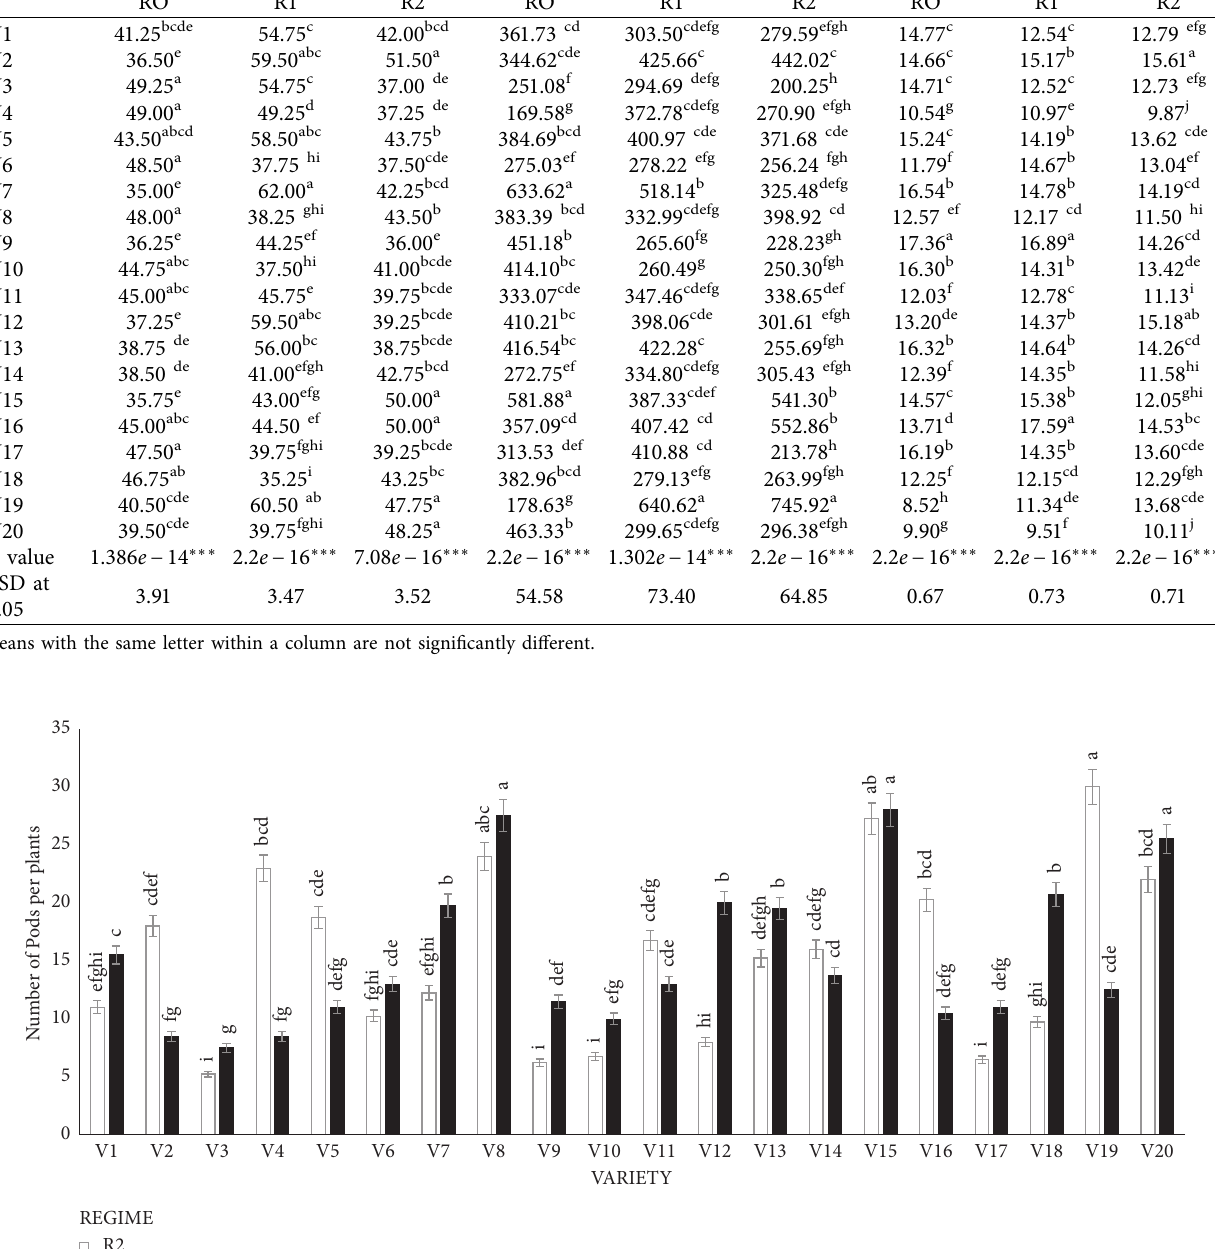
Table 3: Agronomic performance of cowpea varieties under drought stress at both vegetative and reproductive stages.